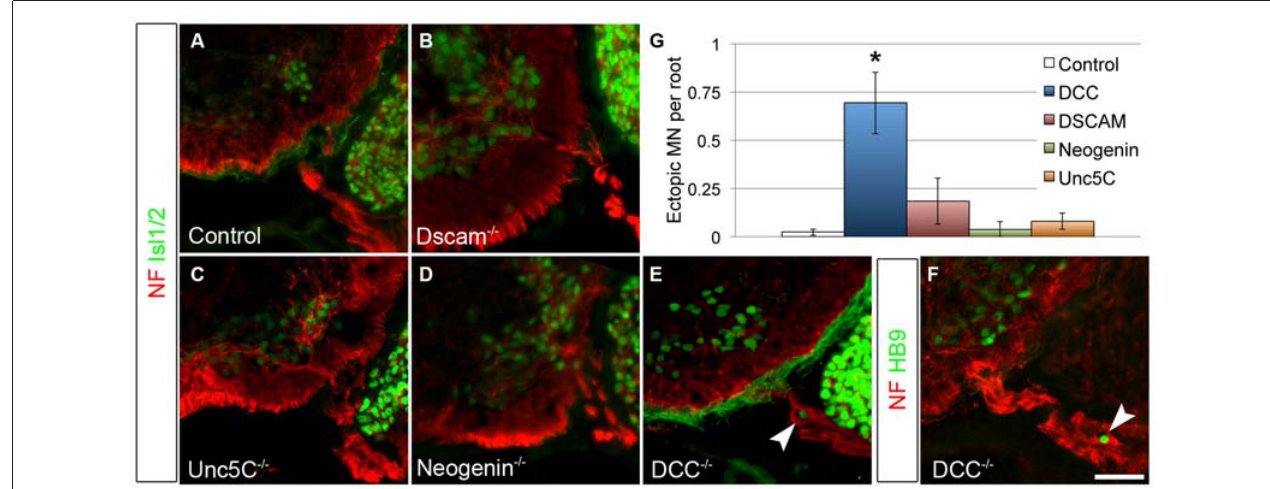
FIGURE 4 | DCC is required to prevent ectopic motor neuron migration . A series of netrin receptor mutant embryos were analyzed at E13.5 for ectopic MNs in the rostral half of the spinal cord. As in controls ( A , n = 3), ectopias were not observed in Dscam ( B , n = 3), Unc5C ( C , n = 3), or Neogenin ( D , n = 2) mutants. There were, however, ectopic MNs in DCC mutants ( n = 4) positive both for Islet 1/2 (E) and HB9 (F) . Quantified in (G) . Scale bar in (F) is 50 µ m. ∗ indicates P < 0.05 by Tukey’s post hoc